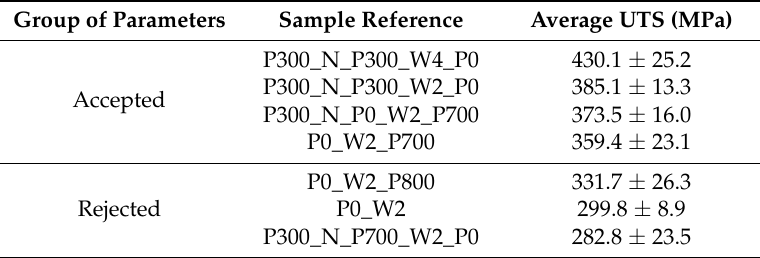
Figure 9. High strength DCI base material without etching (magnification 200×).